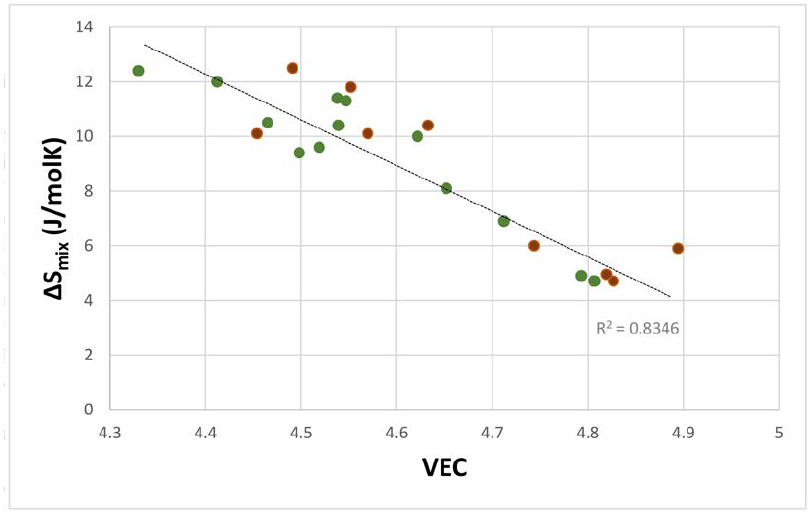
Figure 2. ∆ S mix versus VEC of eutectics with Nb ss and Nb 5 Si 3 in Nb-silicide based alloys with only Ge or Sn. All of the data R 2 = 0.8346, eutectics with only Sn (filled green circles) R 2 = 0.8966, eutectics with only Ge (filled brown circles) R 2 =